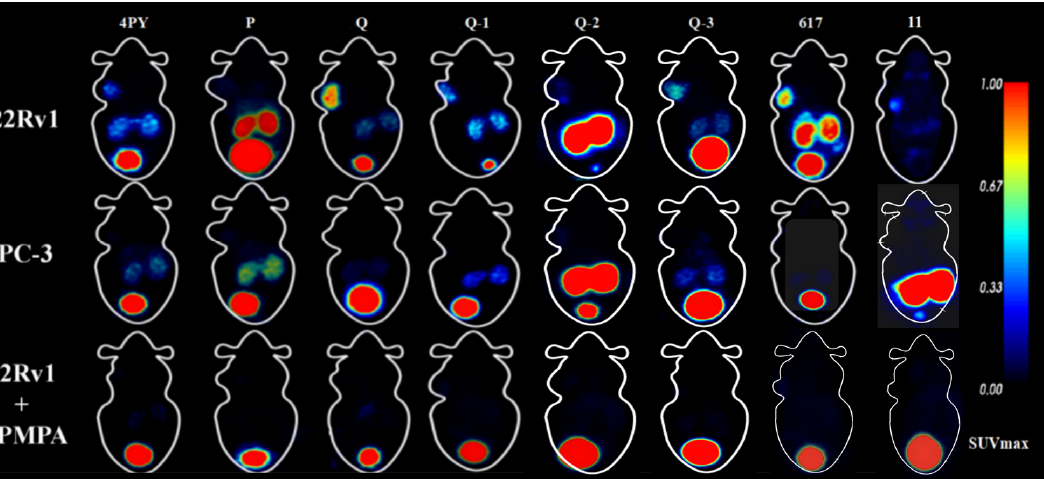
Figure 7. Micro-PET MIP images of novel tracers, [ 68 Ga]Ga-PSMA-617, and [ 68 Ga]Ga-PSMA-11 in 22Rv1 and PC-3 tumor-bearing mice at 60 min p.i..